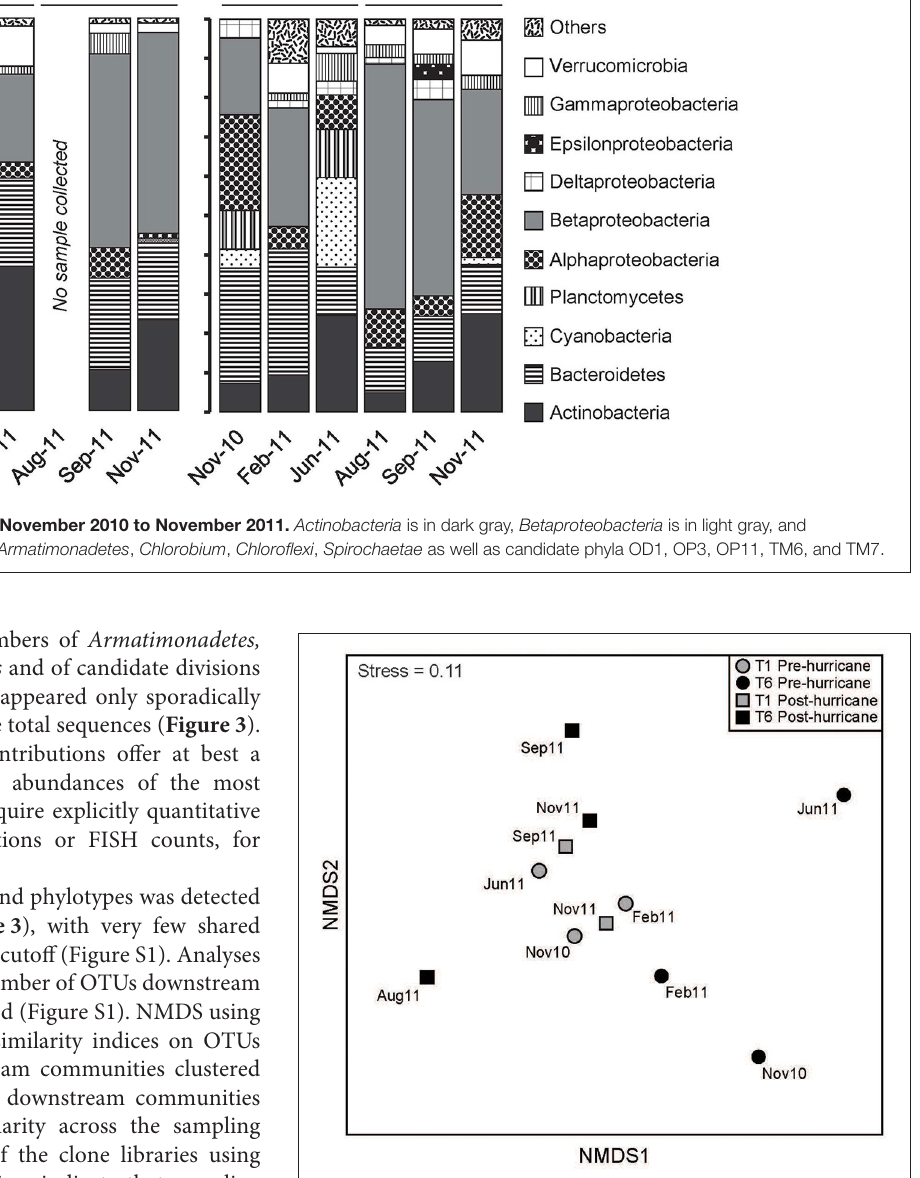
FIGURE 4 | Non-metric Multidimensional Scaling (NMDS). Bray-Curtis dissimilarity index was used to calculate the dissimilarity matrix for bacterial community composition at an OTU cutoff of